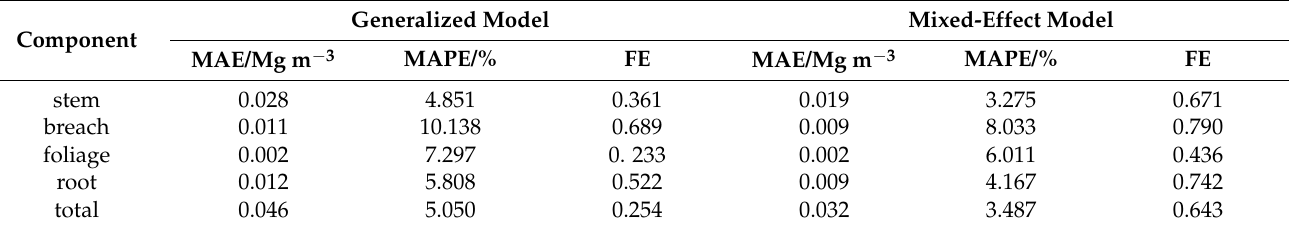
Table 9. Testing Results of the Model of BCEF s for Natural White Birch